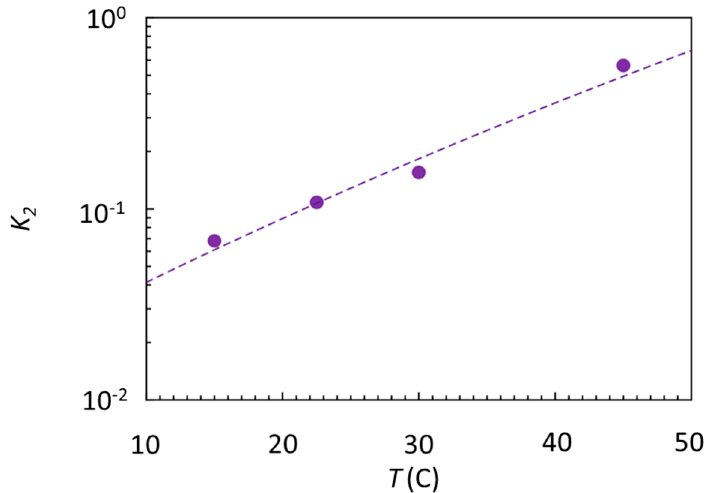
Figure 4. Effect of temperature on the Gal4–DNA interaction. Estimated specific equilibrium dissociation coefficient K 2 (dots) obtained from the ratio of the dissociation constants measured on spots of specific and nonspecific strands according to Equation (3).